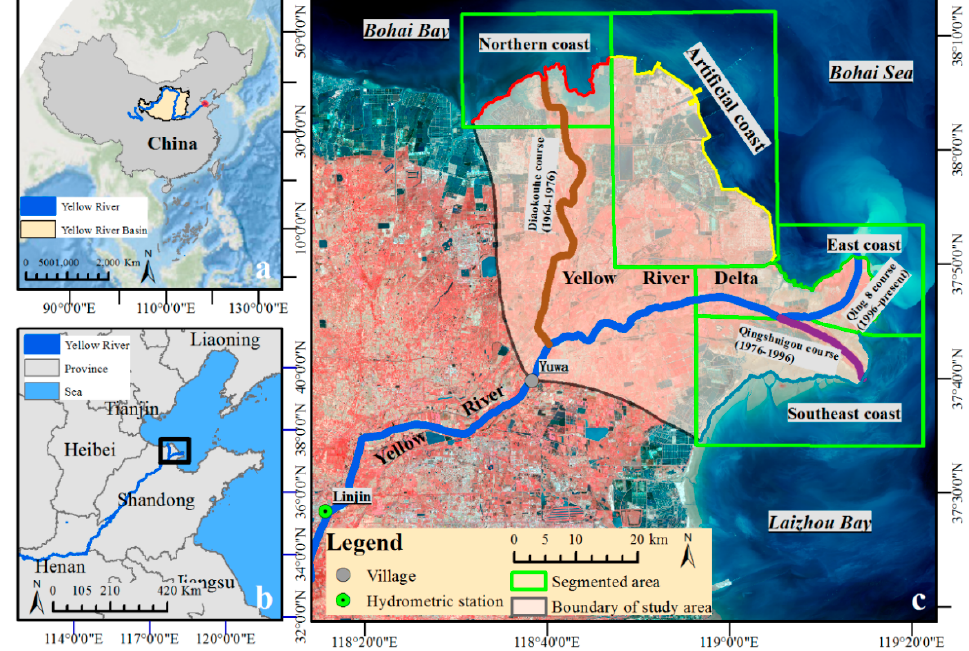
Figure 1. Location of the Yellow River and its basin ( a ), the Yellow River Delta in Shandong Province, China ( b ), and the study area ( c ). The background of ( c ) is a standard false color image of Landsat 8 Operational Land Imager (OLI) taken on 19 October 2018. Coordinates in Universal Transverse Mercator projection (UTM), Zone 50 North, WGS84.